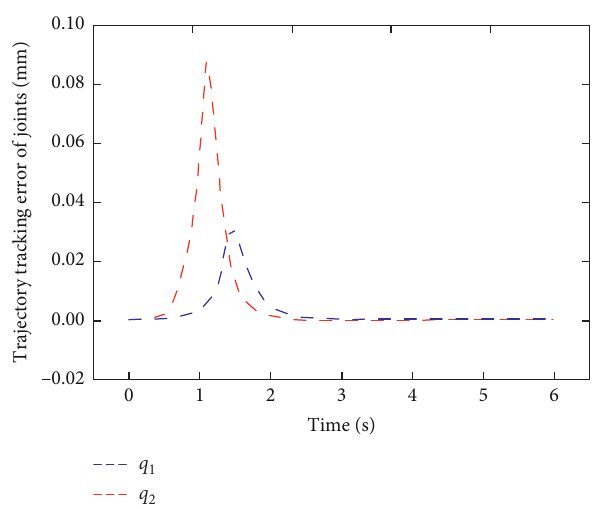
Figure 7: Trajectory tracking errors of the two-link robotic manipulator in joint space.